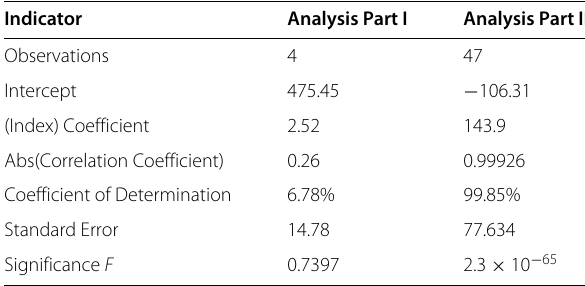
Table 2 FIFS Transmission’s Regression Analysis Output